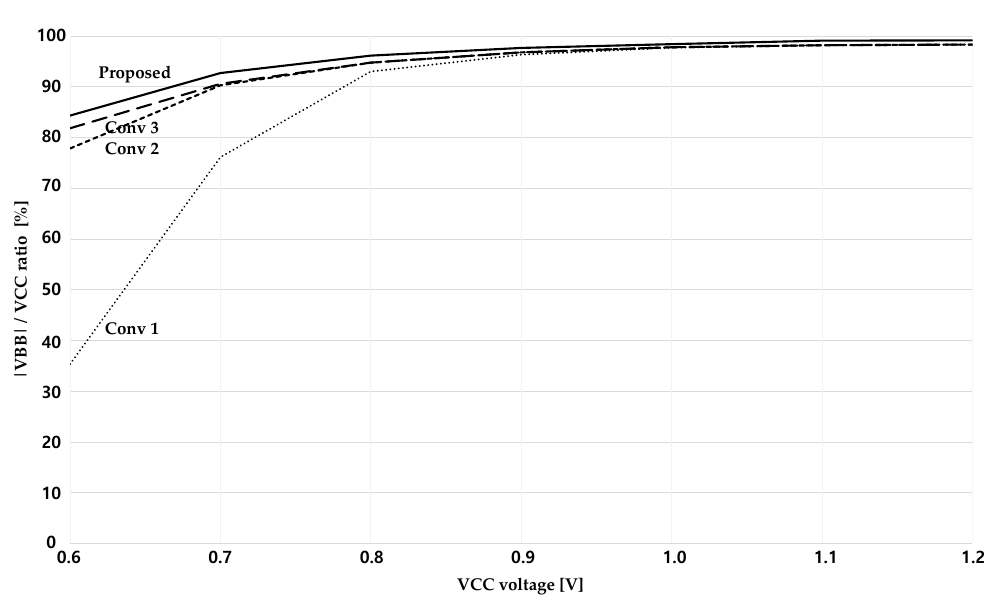
Figure 6. Pump-down speed. Electronics 2020 , 9 , x FOR PEER REVIEW